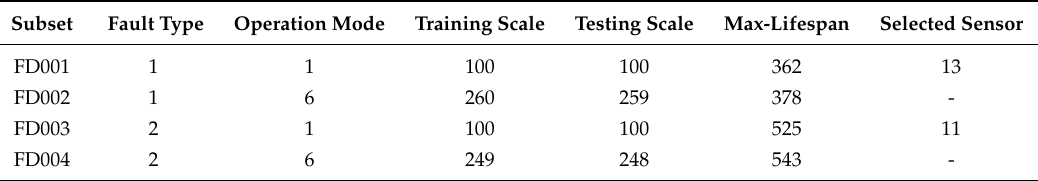
Figure 4. The prediction results of the proposed model for synthetic data. ( a ) The sample of exponential function with ( a exp = 0.01, b exp = 0.25 ) . ( b ) The sample of exponential function with ( a exp = 0.02, b exp = 0.5 ) . ( c ) The sample of exponential function with ( a exp = − 0.04, b exp = 1.3 ) . ( d ) The sample of exponential function with ( a exp = − 0.06, b exp = 1.6 ) . Table 2. Detailed information of C-MAPSS